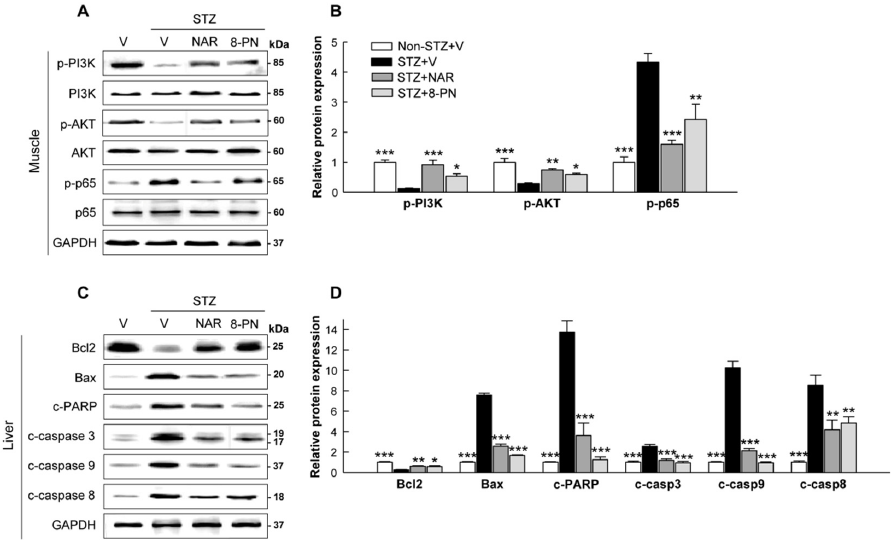
Figure 5. Effects of naringenin and 8-PN on insulin-signaling defect in skeletal muscle and hepatic apoptosis. ( A ) Representative Western blot images of phospho-PI3K, PI3K, phospho-AKT, AKT, phospho-p65, and p65 in the skeletal muscle and ( B ) corresponding quantitative data. ( C ) Repre- sentative Western blot images of Bcl2, Bax, cleaved PARP, cleaved caspase-3, cleaved caspase-9, and cleaved caspase-8 in the liver and ( D ) corresponding quantitative data. V, vehicle; NAR, naringenin; 8-PN, 8-prenylnaringenin. Data are shown as means ± SEM (n = 6). * p < 0.05, ** p < 0.01, *** p < 0.001 vs. STZ vehicle group. 2.5. Changes of Estrogen Receptors and FGF21 Protein Expression in Target Tissues Because 8-PN has been classified as a potent phytoestrogen that is structurally sim- ilar to estrogens with ER-agonistic and/or -antagonistic activity, we examined changes in ER α and ER β protein expressions. Interestingly, in the pancreas, skeletal muscle, and liver of STZ-vehicle mice, both ER α and ER β protein expression levels were significantly reduced compared to those of normal control mice (Figure 6A,B). Naringenin and 8-PN differentially regulated ER α and ER β protein expression levels according to target tis- sues. Of note, in STZ-treated mice, ER α expression was normalized by naringenin and 8-PN in the pancreas and by 8-PN in the liver. Additionally, the protein expression of fi- broblast growth factor 21 (FGF21)—a key regulator of glucose metabolism—was re- duced by STZ but increased by naringenin in the pancreas and by 8-PN in the liver (Fig- ure 6C,D).